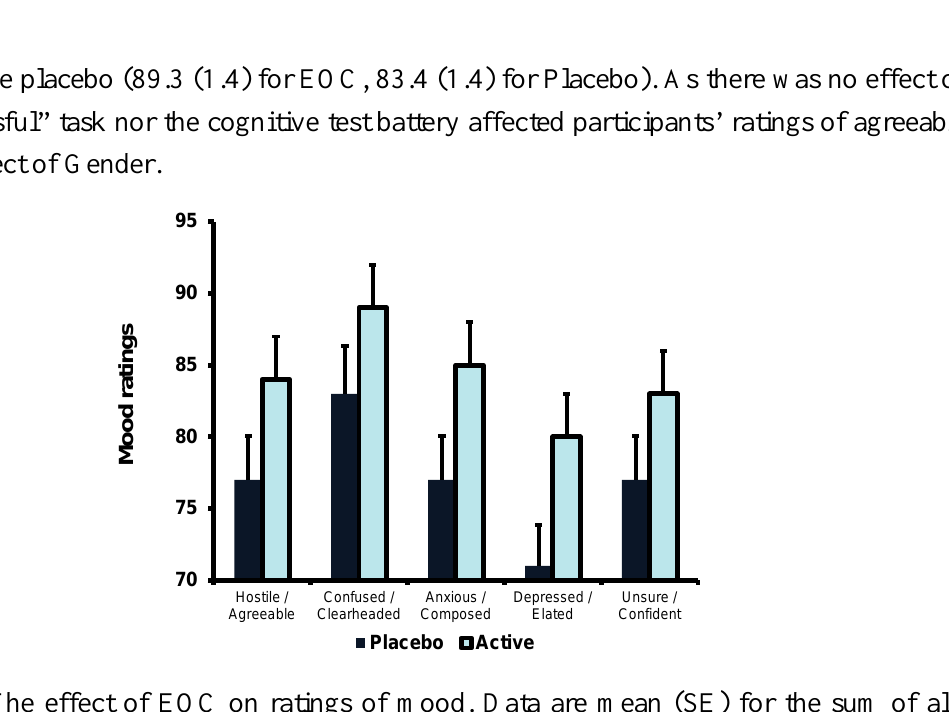
Figure 2. The effect of EOC on ratings of mood. Data are mean (SE) for the sum of all three time points on visit 2 for ratings of agreeableness, clear-headedness, anxiety, depression and confidence. Participants who had drunk EOC, rather than placebo, rated themselves more agreeable ( p < 0.007), more clearheaded ( p < 0.05), less anxious ( p < 0.04), less depressed ( p < 0.01) and more confident ( p <